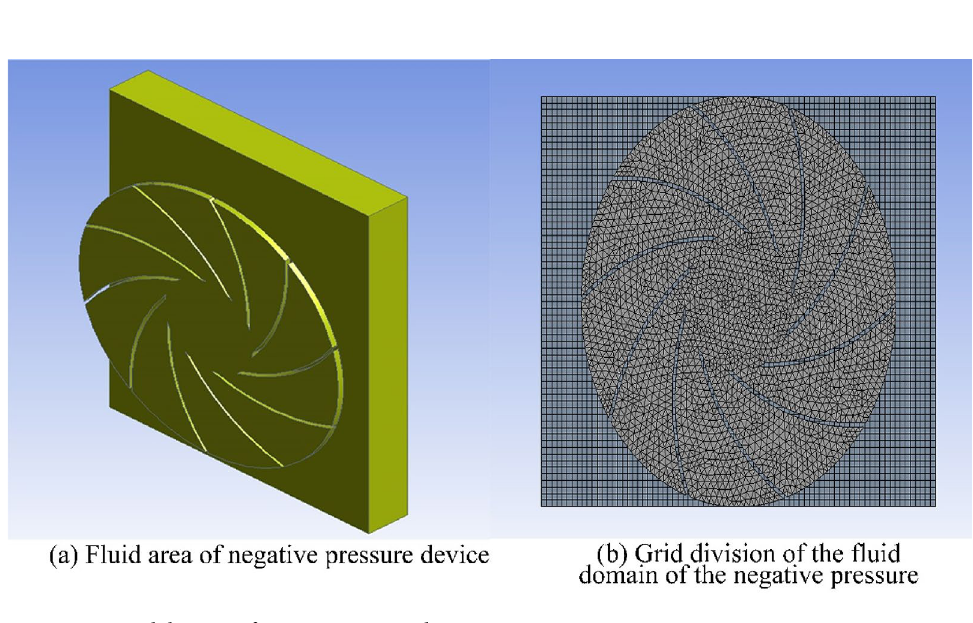
Figure 12. Grid division of negative pressure